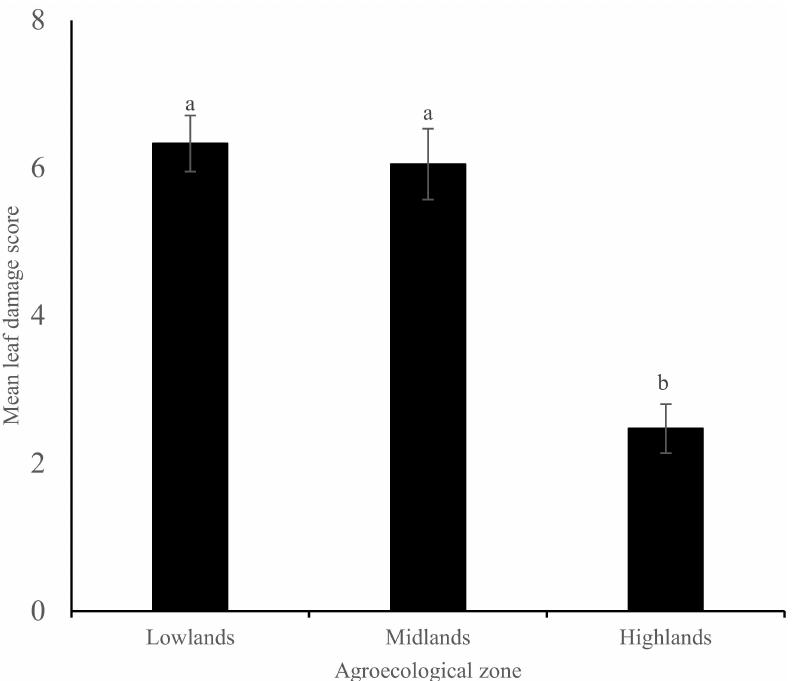
Figure 3. Mean fall armyworm damage score ( ± SE) on leaves of maize plants in three different agro- ecological zones of Kenya. Bars capped with different letter differ significantly (Tukey’s studentized test: p <